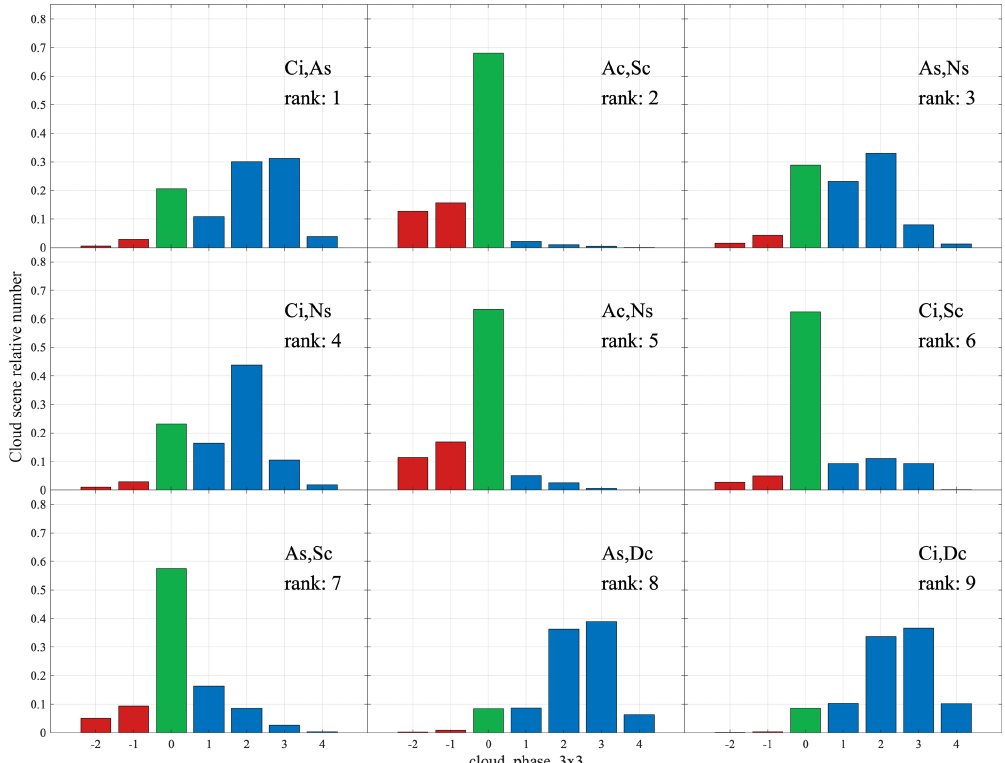
Figure 9. AIRS cloud_phase_3x3 histograms for cloudy sky with multiple cloud types for the top nine ranked cloud scenes in order of occurrence